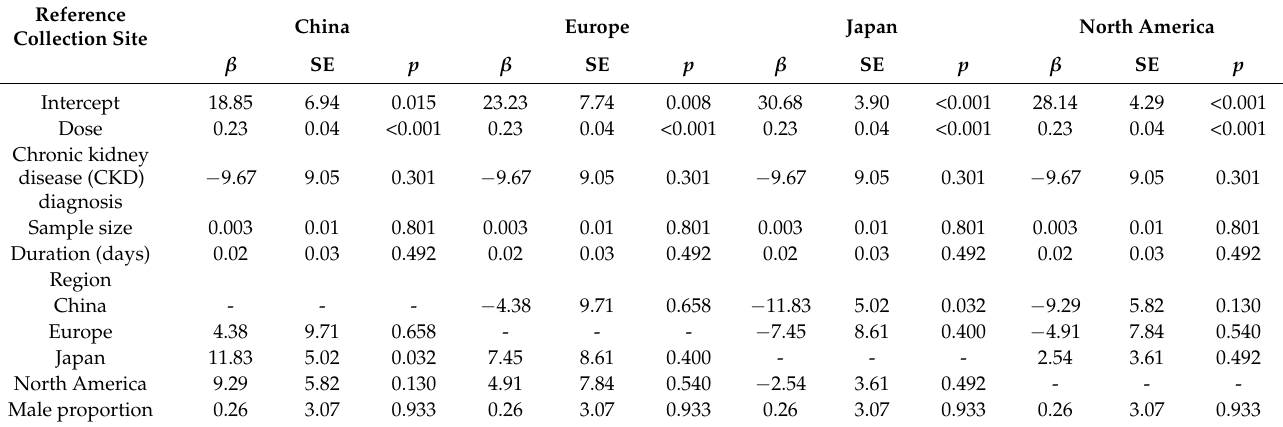
Table 3. Covariate model for febuxostat and post-hoc analyses based on data collection site